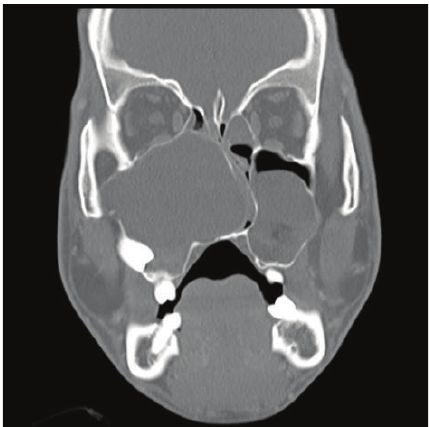
Figure 3: The operative view of the nasal airway (solid arrow) and the balloon catheter (open arrow) devices in the right maxillary sinus.